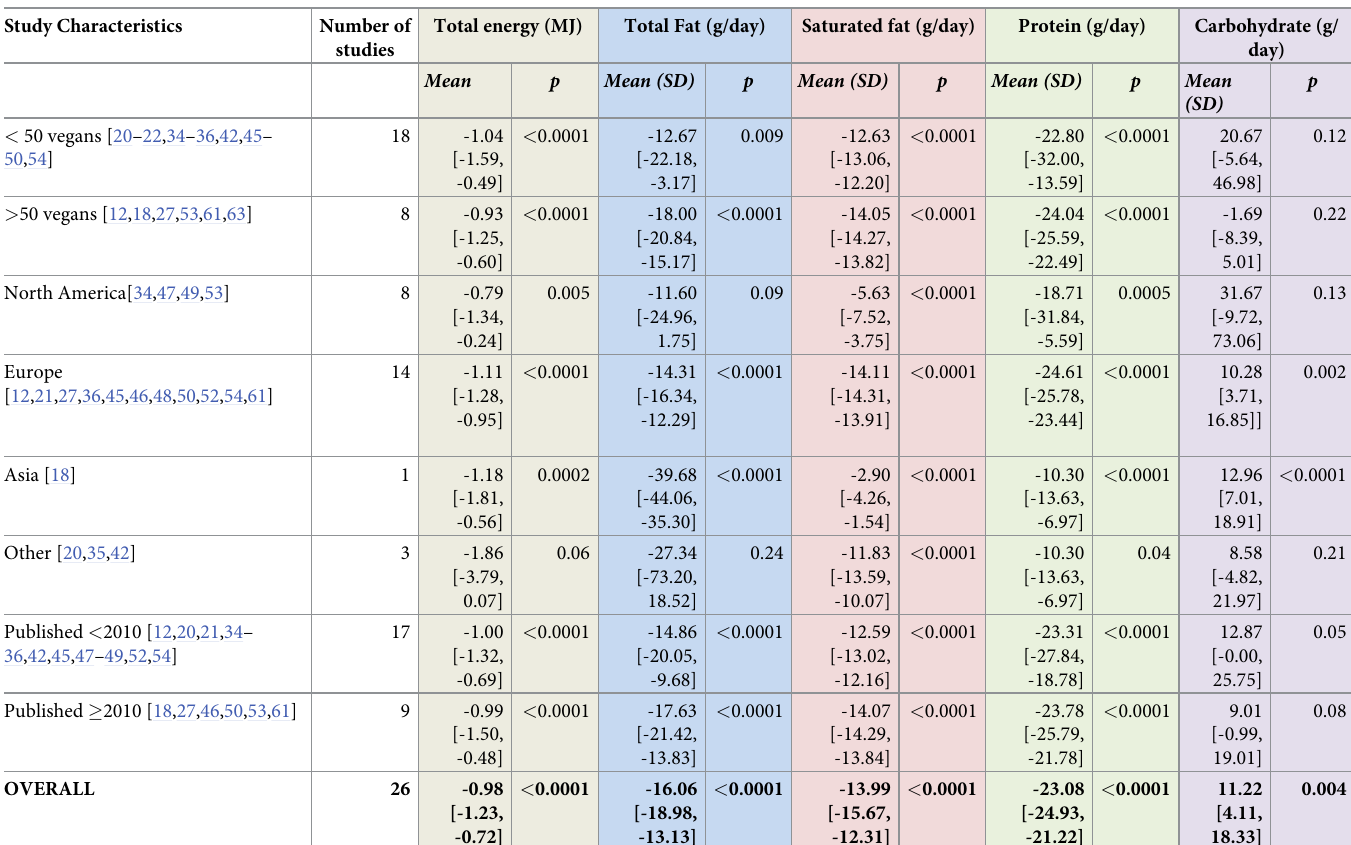
Table 4. Intake of macronutrients in vegans compared to omnivores. Study Characteristics